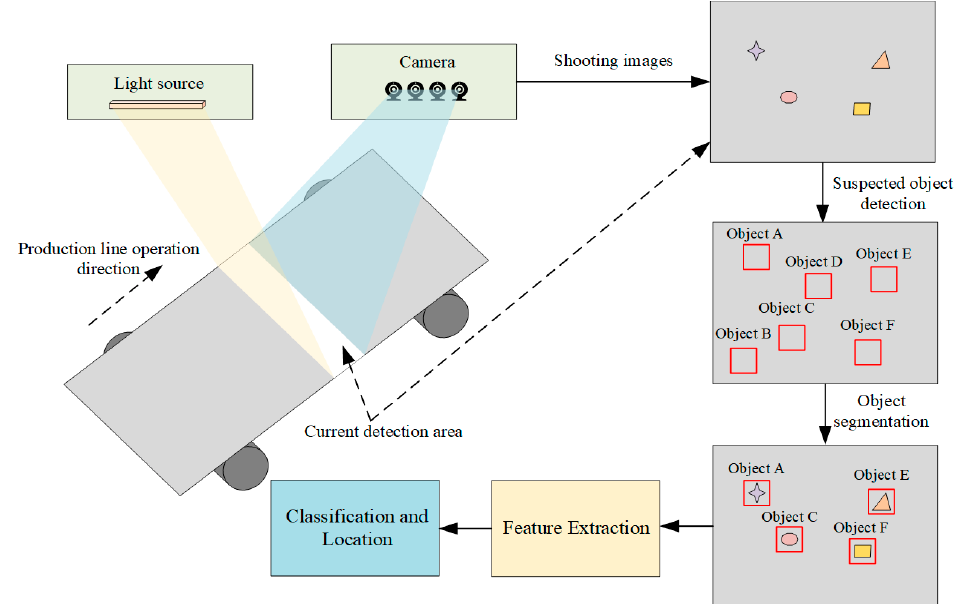
Figure 3. Steel surface defect recognition system.